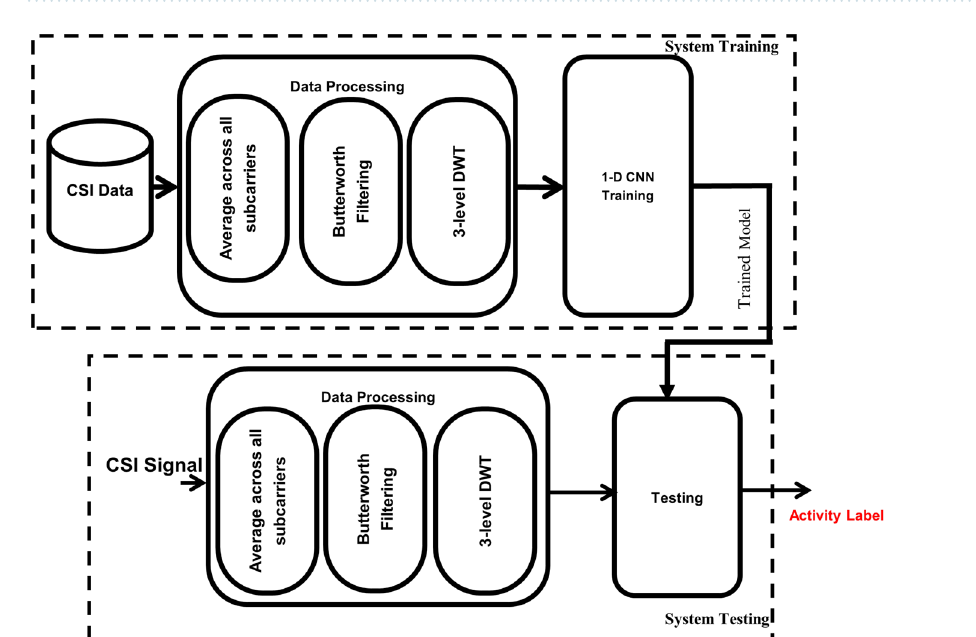
Figure 4. Signal flow diagram for multi-user activity